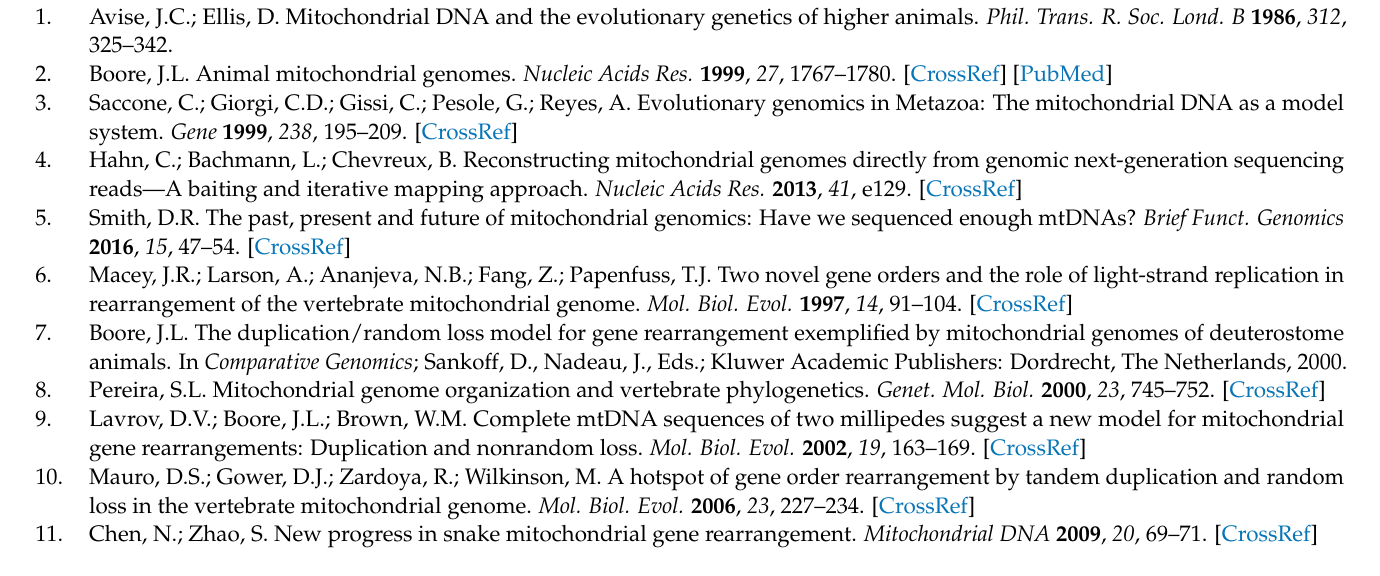
Table S4: Comparison of the composition and skew values of three mitogenomes for P. helioscopus . Table S5: Comparison of the codon usage in mitochondrial protein-coding genes for P. helioscopus varius I, P. helioscopus varius II and P. helioscopus cameranoi . Table S6: Twenty-five Phrynocephalus mitogenomes analyzed in gene rearrangement with their GenBank accession